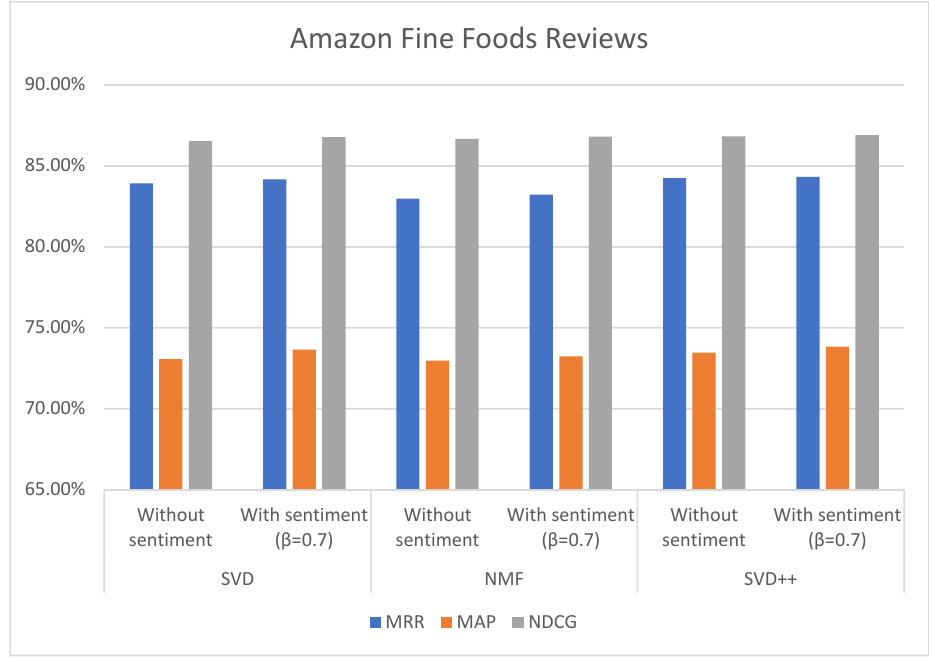
Figure 12. MRR, MAP, and NDCG values without and with C-LSTM sentiment model on Amazon Fine Foods Reviews with β =